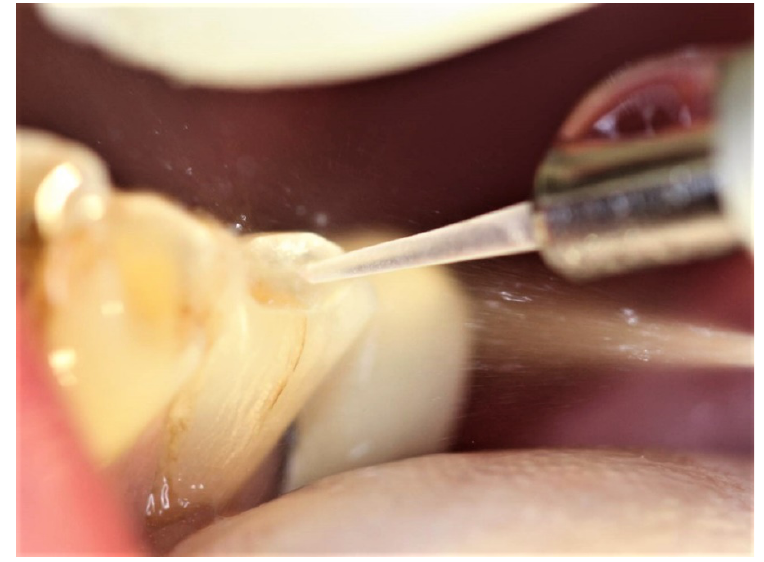
Figure 10. Use of the er YAG laser in tooth cavity preparation. Note the co-axial water spray to aid dispersal of ablation debris and cool the target hard tissue site. dispersal of ablation debris and cool the target hard tissue